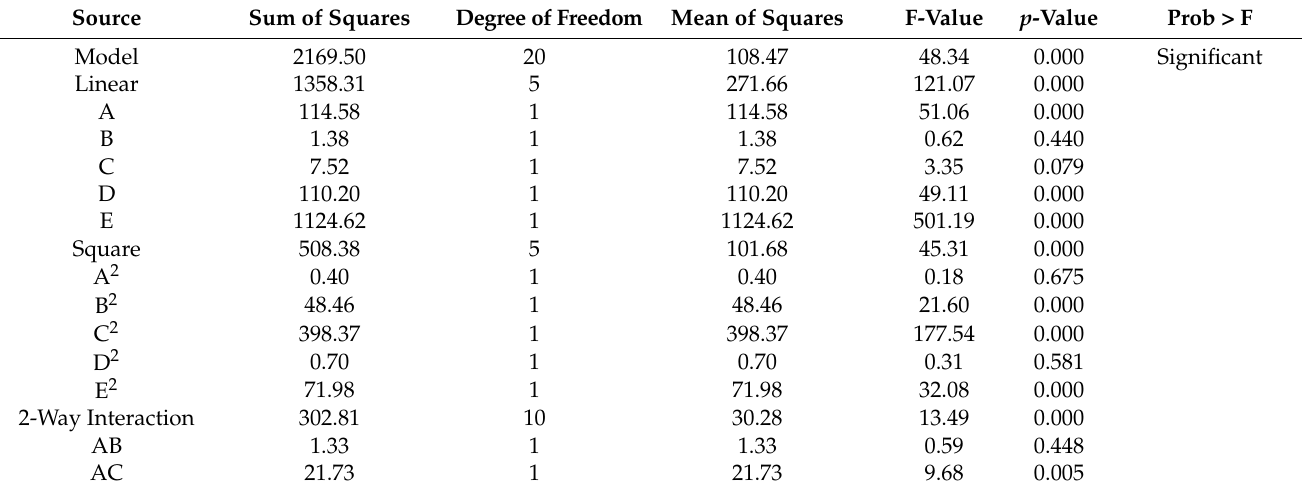
Table 6. ANOVA for the experimental results of pectinase biosynthesis by M. circinelloides